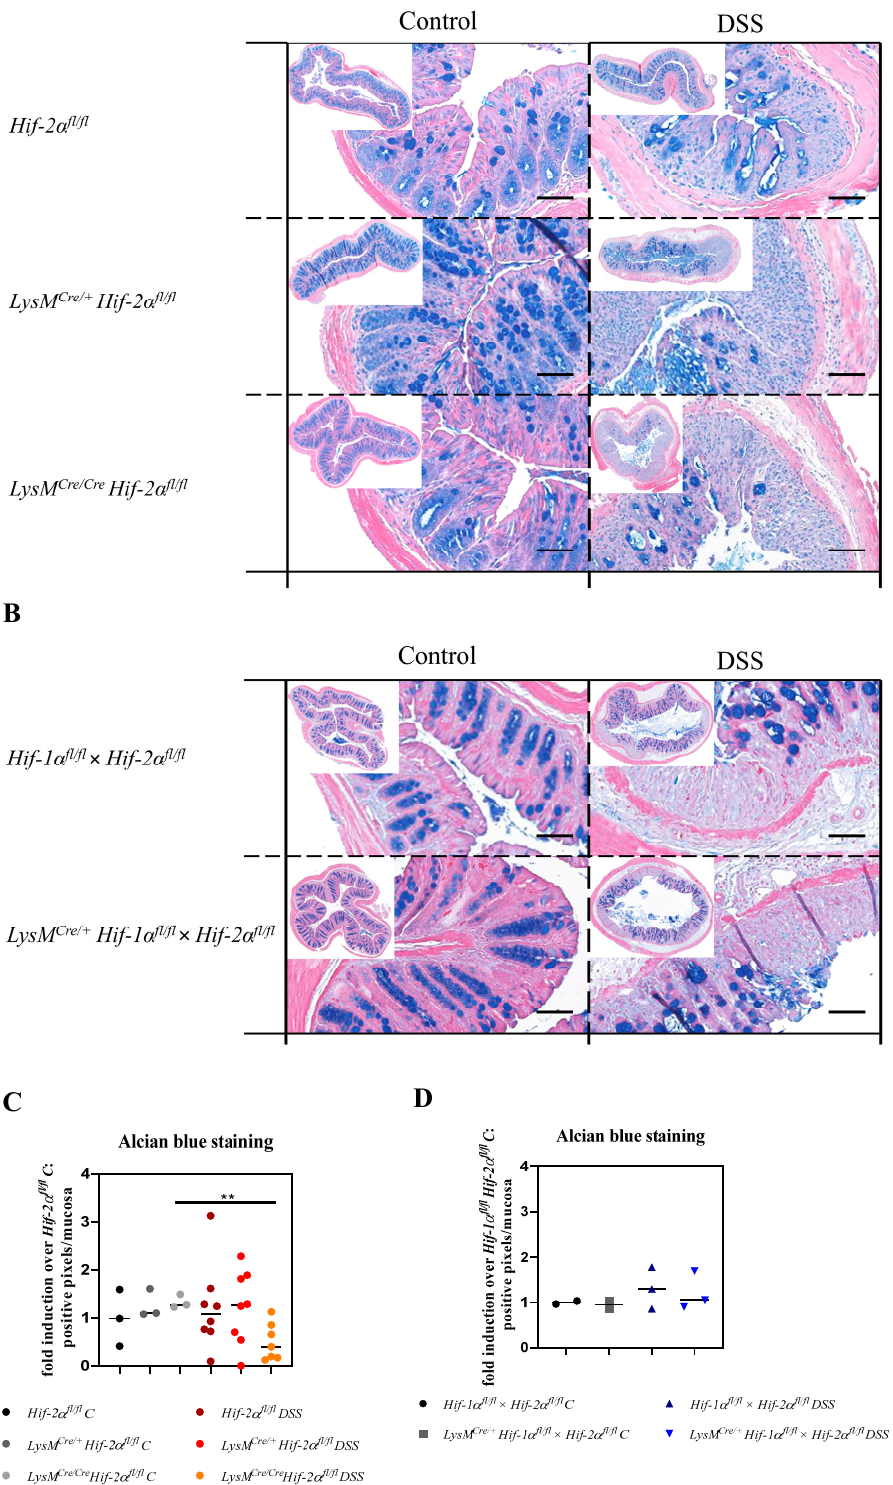
Figure 4. Reduced mucin production after tissue destruction. Exemplary presentation of alcian blue-stained colon tissue sections of ( A ) Hif-2 α fl/fl , LysM Cre/+ Hif-2 α fl/fl and LysM Cre/ Cre Hif-2 α fl/fl animals and ( B ) Hif-1 α fl/fl × Hif-2 α fl/fl and LysM Cre/+ Hif-1 α fl/fl × Hif-2 α fl/fl animals with and without DSS treatment and quantification of histological data ( C , D ). No positive alcian blue staining was observed in damaged colon areas. Statistical analysis was performed with an unpaired t -test; ( A ): n (Control) = 3 ( LysM Cre/ Cre Hif-2 α fl/fl )/5 ( Hif-2 α fl/fl , LysM Cre/ + Hif-2 α fl/fl ), n (DSS) = 8 ( LysM Cre/ Cre Hif-2 α fl/fl )/12 ( Hif-2 α fl/fl , LysM Cre/ + Hif-2 α fl/fl ), ( B ): n (Control) = 2, n (DSS) = 3. counterstaining: eosin. Magnification overview image: 100×; magnification detail image: 200×; and scale bar: 100 µm, ( C , D ): every indicated spot depicts the quantitative analysis of a complete cross section of one colon. **: p < 0.01. 2.4. Macrophage Migration towards the Inflamed Colon is not Altered by Myeloid HIF-2 α Knockout Due to the fact that macrophages played a crucial role in the DSS model of LysM Cre/+ Hif-1 α fl/fl - animals [15] and that macrophages are the cells carrying the knockout analyzed herein, the F4/80 protein was detected in colon tissue sections with the help of a specific antibody. The control groups showed only a few F4/80-positive cells in the lamina propria mucosae and sporadically in the tela submucosa . In the tissue sections of the DSS-treated animals, there was a clear increase in the number of F4/80-positive cells in the lamina propria mucosae and in the tela submucosa . However, there were no clear differences between the different genotypes within the DSS-treated